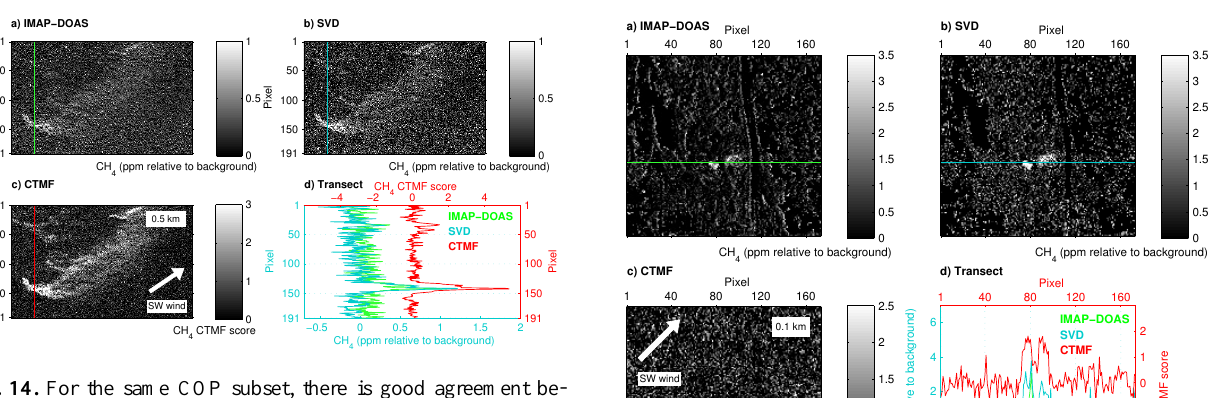
Fig. 14. For the same COP subset, there is good agreement be- tween results obtained using three techniques: (a) IMAP-DOAS, (b) SVD, and (c) cluster-tuned matched filter (CTMF). (d) The lo- cation of a vertical transect is shown for the IMAP-DOAS (green line), SVD (cyan), and CTFM results (red); values along the tran- sect are shown for IMAP-DOAS (green), SVD (cyan), and CTMF (red). At each point along the transect, an average value was calcu- lated for 21 pixels centered on the transect in the horizontal direc- tion. IMAP-DOAS and SVD transects share the cyan figure axes, while the CTMF transect was offset for clarity and corresponds to the red figure axes.